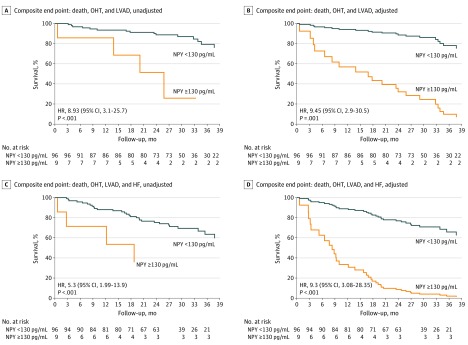
Coronary Sinus Neuropeptide Y (NPY) Levels and Major Adverse Cardiac Events (MACE) A and B, Kaplan-Meier survival analysis for MACE (death, heart transplantation [OHT], or ventricular assist device [VAD] placement) as a function of NPY before (A) and after (B) adjusting for age (hazard ratio [HR], 0.998; 95% CI, 0.95-1.05; P = .93), estimated glomerular filtration rate (eGFR) greater than 45 mL/min compared with less than 45 mL/min (HR, 0.325; 95% CI, 0.11-0.96; P = .04), and left ventricular ejection fraction (LVEF) per 1% increase (HR, 0.93; 95% CI, 0.86-1.01; P = .07), with subanalysis into groups with NPY levels 130 pg/mL or less and NPY levels greater than 130 pg/mL. C and D, Kaplan-Meier survival analysis for MACE (death, OHT, VAD placement, or heart failure hospitalization) as a function of NPY before (C) and after (D) adjusting for age (HR,  0.943; 95% CI, 0.91-0.98; P = .001), eGFR greater than 45 mL/min vs less than 45 mL/min (HR, 0.099; 95% CI, 0.038-0.258; P < .001), and LVEF per 1% increase (HR, 0.92; 95% CI, 0.88-0.97; P = .002), with subanalysis into groups, with NPY level of 130 pg/mL or less and NPY level greater than 130 pg/mL. HF indicates heart failure.